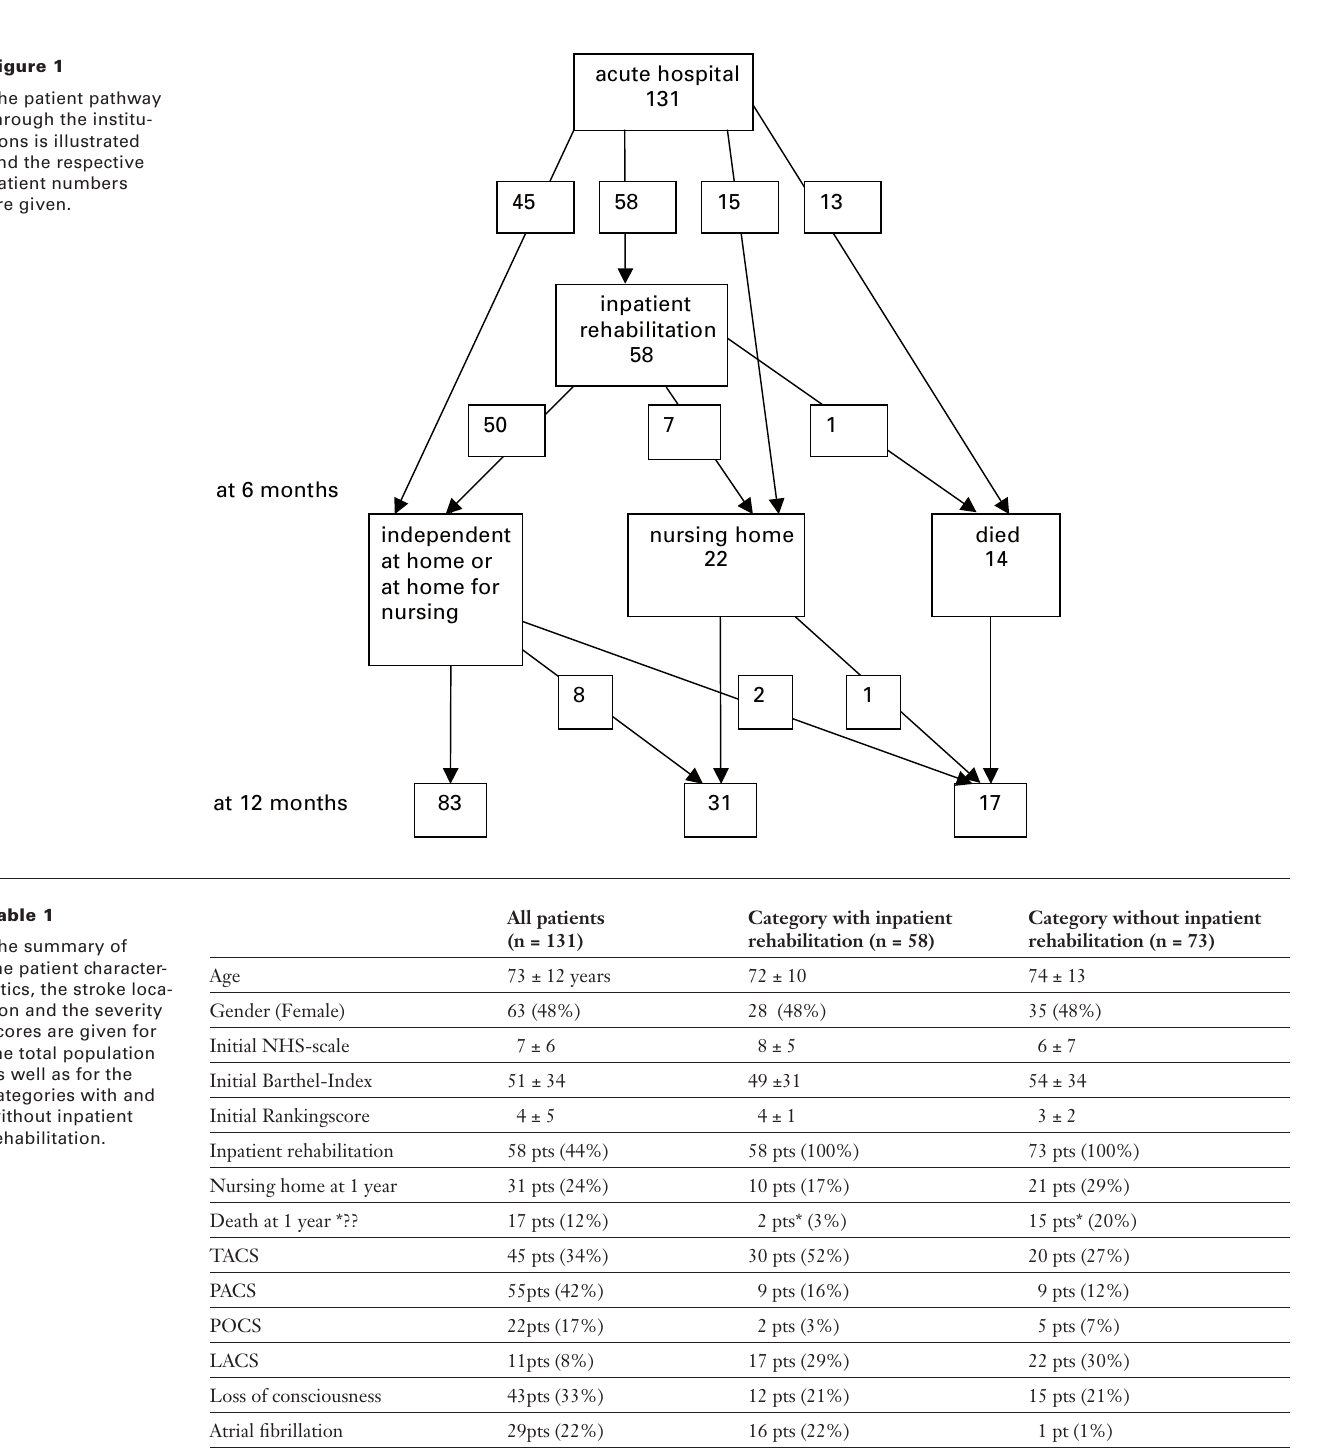
The summary of the patient character- istics, the stroke loca- tion and the severity scores are given for the total population as well as for the categories with and without inpatient rehabilitation.